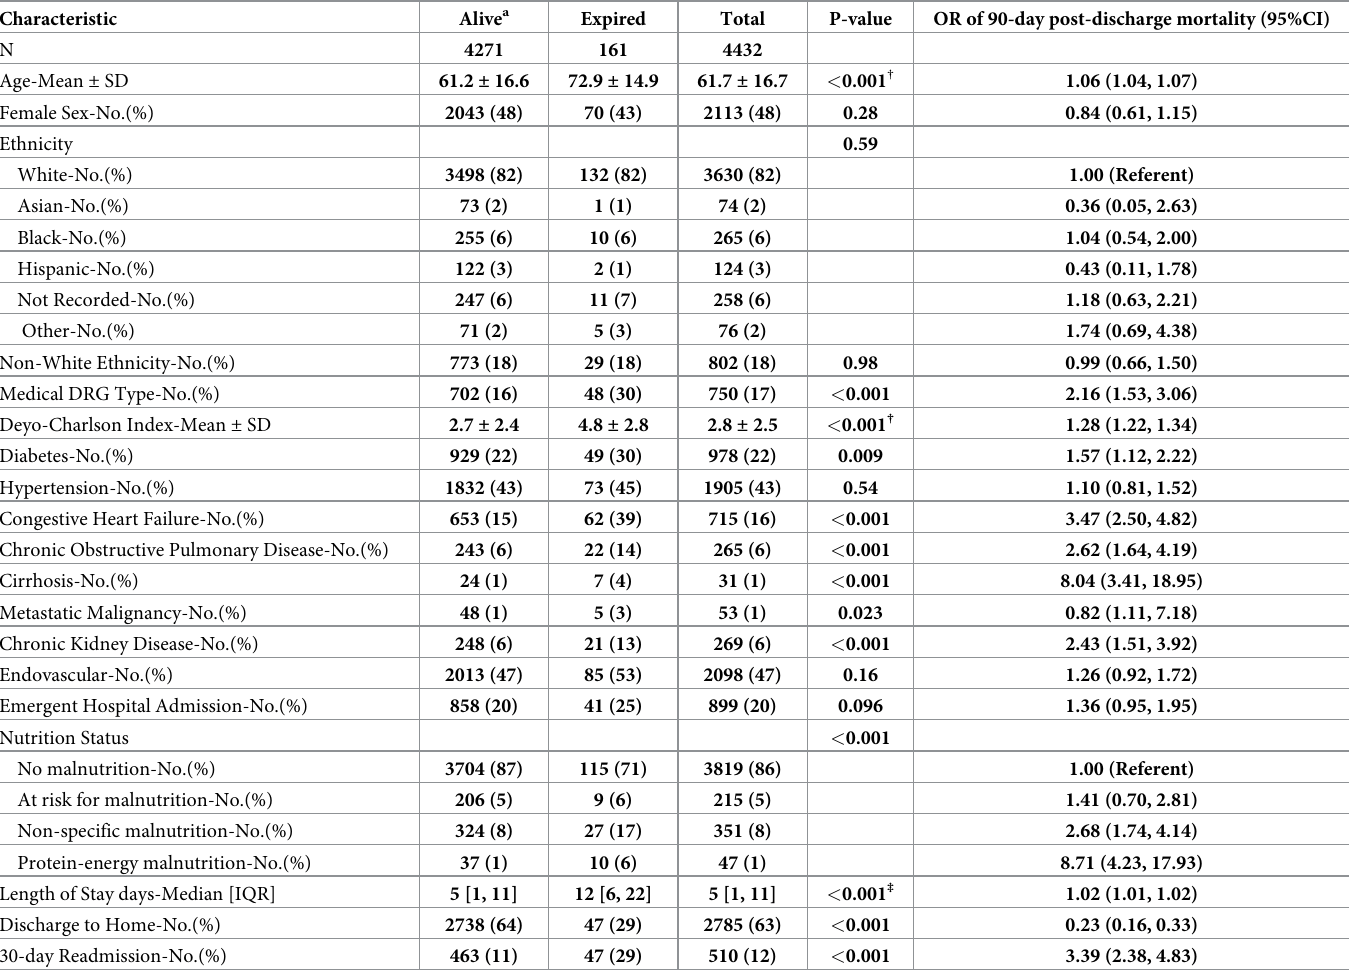
Table 1. Characteristics and unadjusted association of potential prognostic determinants of 90-day post discharge mortality a (n = 4,432).